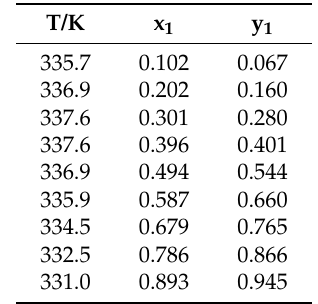
Table A1. Vapor-liquid equilibrium data for the acetone (1) + chloroform (2) system at 101.3 kPa.